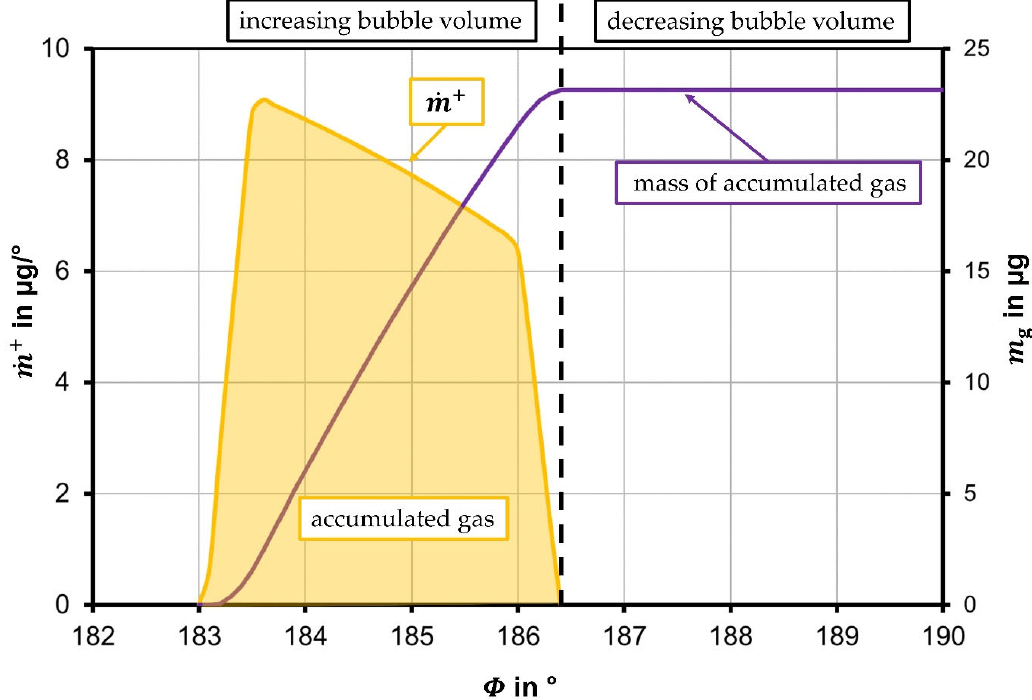
Figure 17. Mass flow rate for bubble growth and total mass of released gas after initiation of transient radial displacement, fluid: paraffin containing 100% dissolved air.